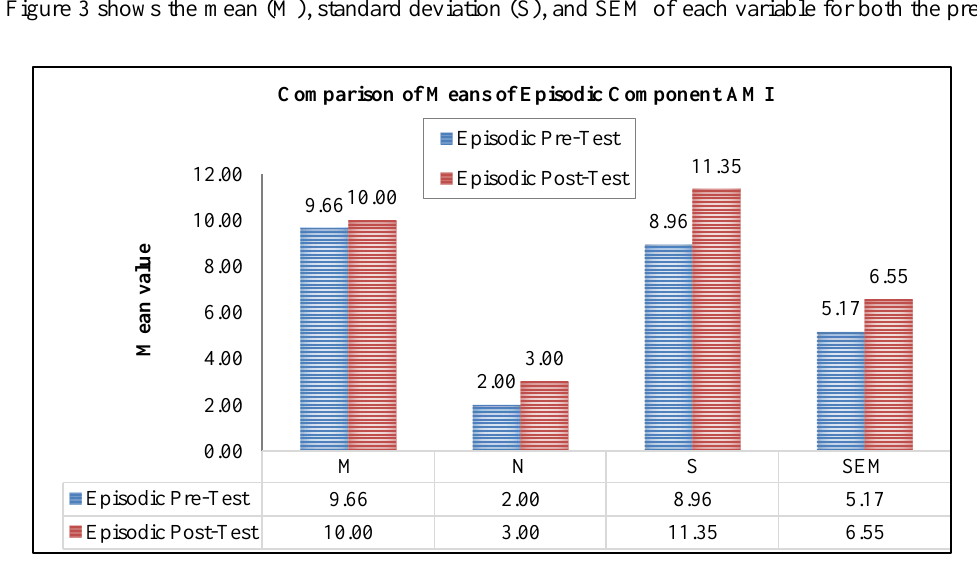
Figure 3. Statistical comparison of the episodic component of the Autobiographical Memory Interview pre- and